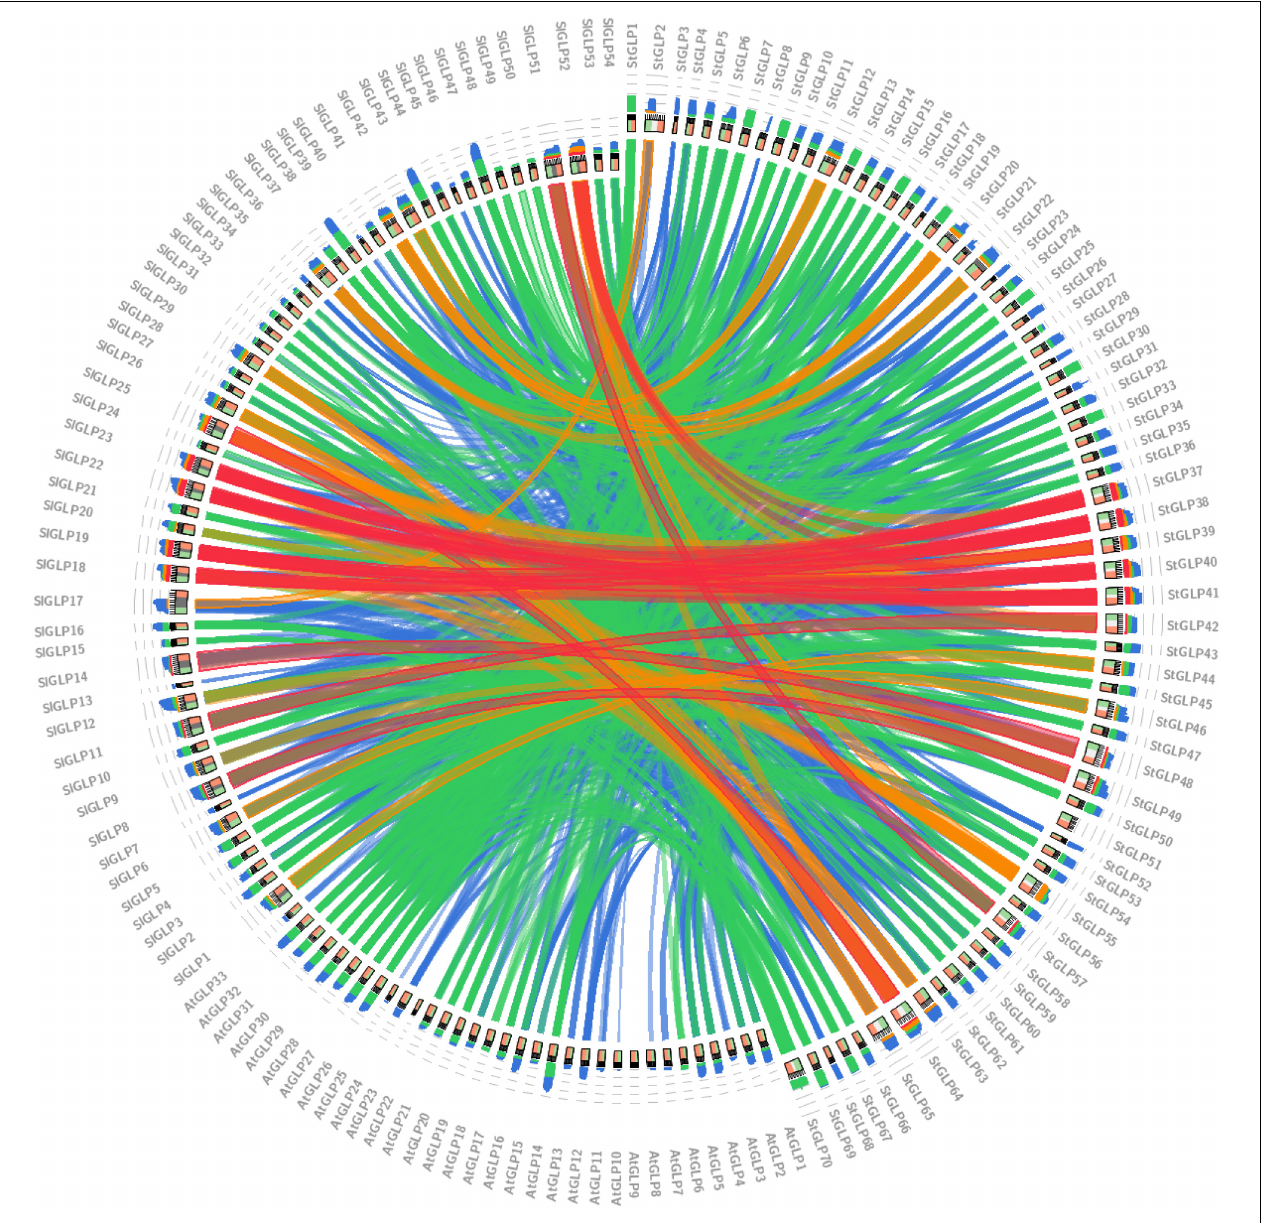
FIGURE 4 | Synteny analysis of GLPs among potato, tomato, and Arabidopsis genomes. In comparative synteny analysis, the color and intensity of inward and outward tangling of ribbons showed conservation and duplication events,